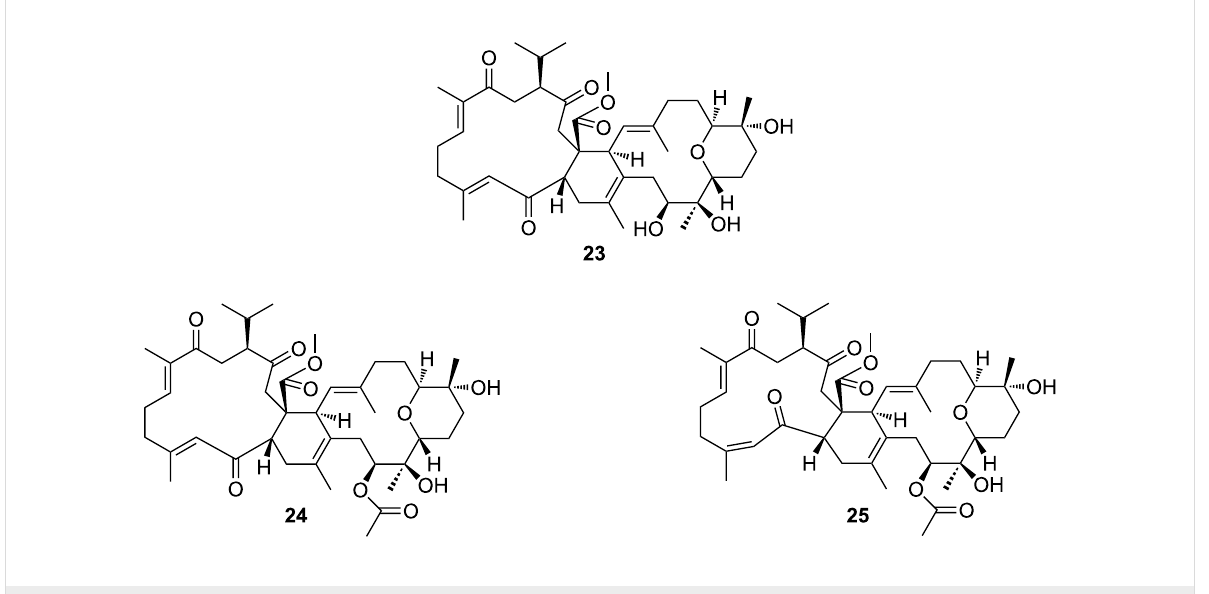
Figure 9: Structures of bisglaucumlids A–C ( 23 – 25 ).